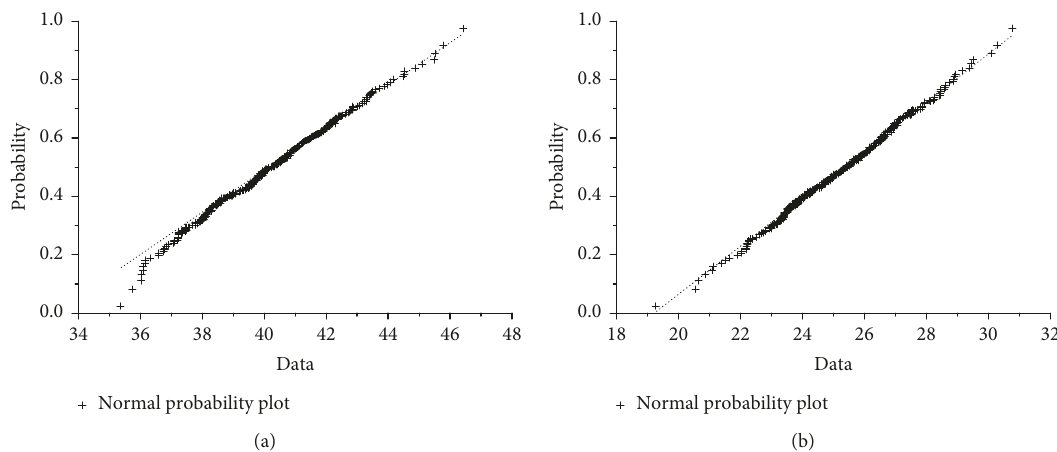
Figure 7: The distribution probability diagram of the daily extreme value of axial uniform temperature in May. (a) The maximum. (b) The minimum.